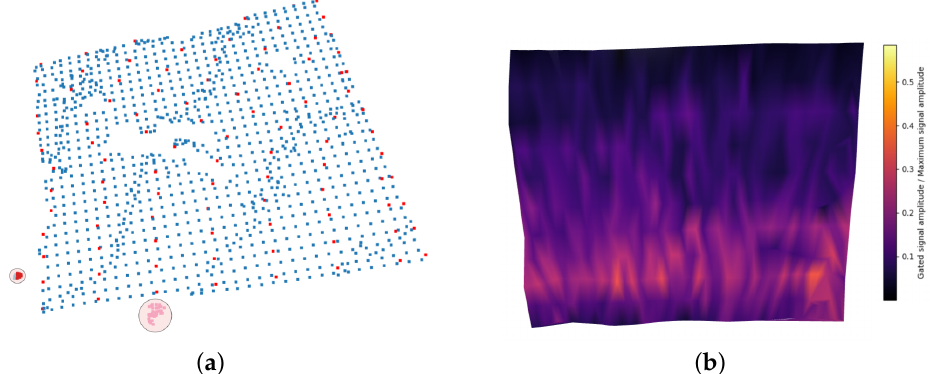
Figure 6. Point cloud and C-scan of the part. The average error of RGB/D point cloud poses from the best fit plane of the collected laser data is 14.7 mm. ( a ) Point cloud map of a reflective CFRP component. Some sections of the point-cloud are missing, the surface data is considerably irregular. Visual artefacts incorrectly placed within the part are circled. ( b ) Heat-mapped C-scan of the part. The 5 mm thickness of the CFRP component placed the back-wall signal within the dead-zone of the 5 MHz probe. The support strut of the part can be seen within the gated region as